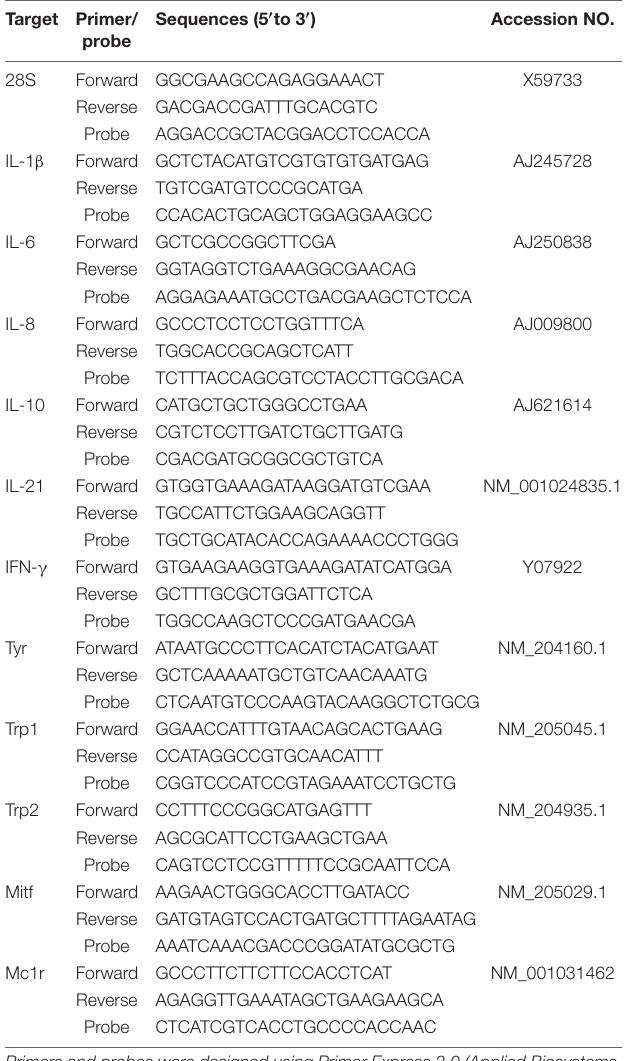
TABLE 1 | Primer and probe sequences for relative expression analysis of chicken target genes. Target Primer/ Sequences (5 (cid:48) to 3 (cid:48) ) Accession probe